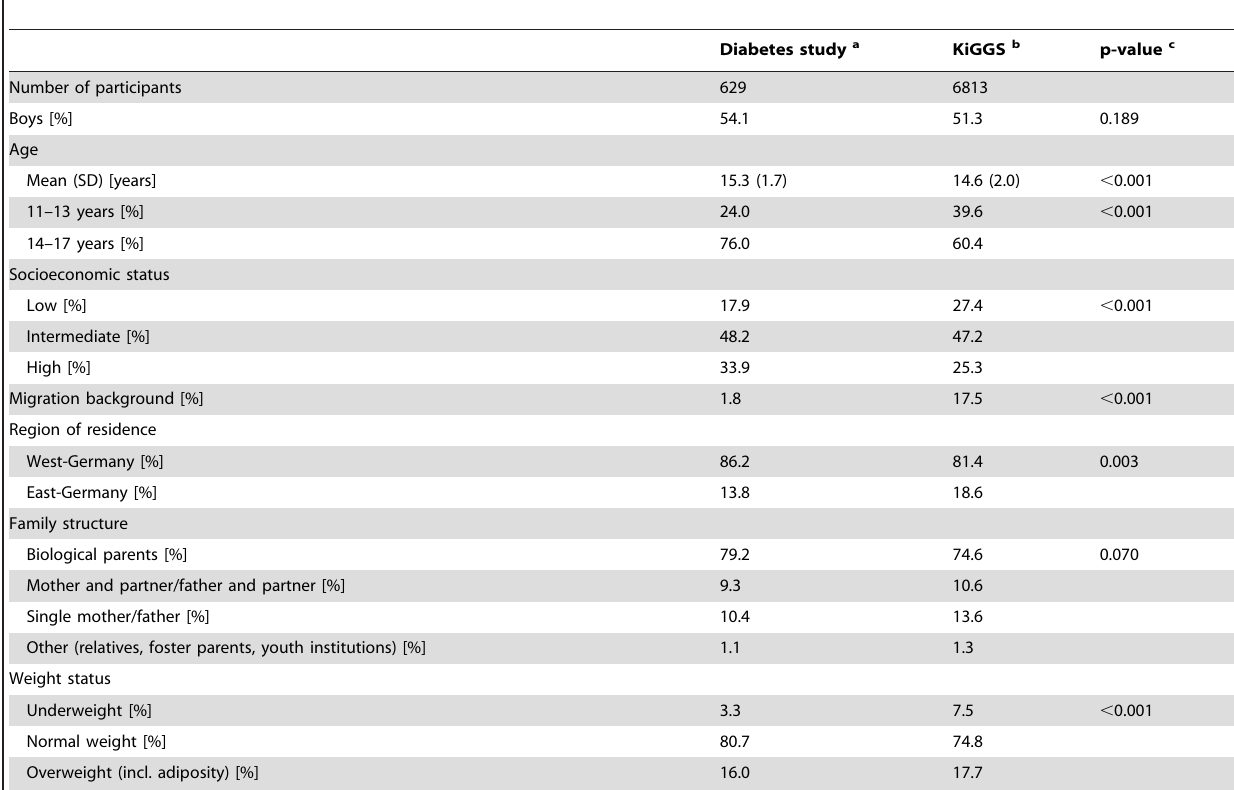
Table 1. Description of the two study